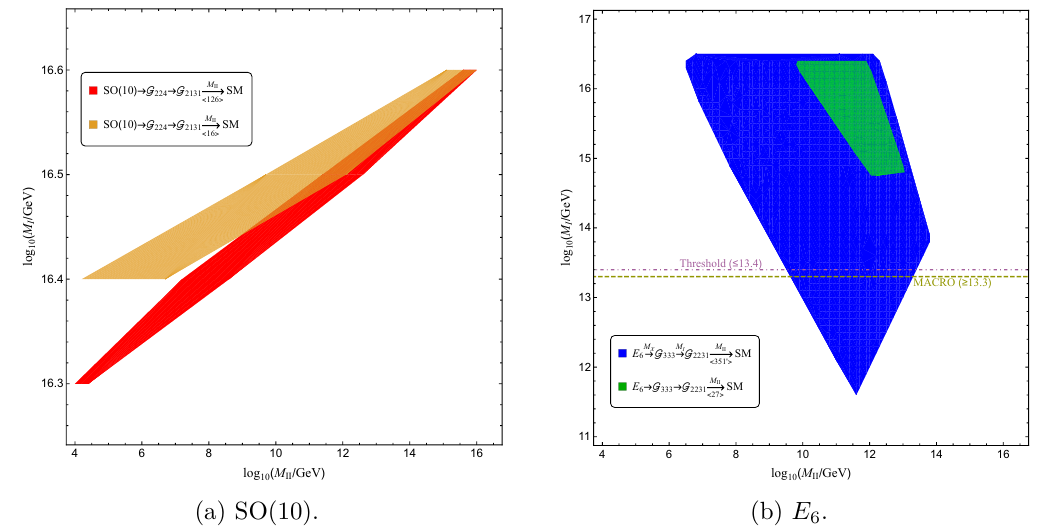
( M GeV) ∈ [16 . 55 , 16 . 63] in the Figure 7. Intermediate breaking scales M I and M II for log X / 10 case of SO(10) and log ( M GeV) ∈ [16 . 43 , 16 . 51] in the case of E with successful inflation X / 6 10 based on a Coleman-Weinberg potential. We also show the two bounds M and M on M I + I − I derived by using eq. (6.9). Namely, the horizontal lines at log ( M GeV) = 13 . 3 (dashed) and I + / 10 log ( M GeV) = 13 . 4 (dot-dashed) represent the MACRO bound and the upper bound on M I − / I 10 for observability of the monopole flux (for M ’s above this value, the monopoles are too diluted to I be